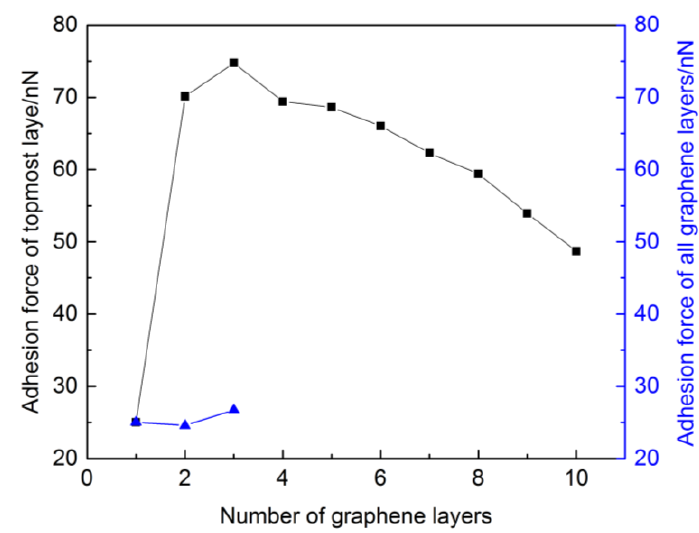
Figure 16. The adhesion forces required to exfoliate the topmost layer and all layers of graphene for different numbers of graphene layers.